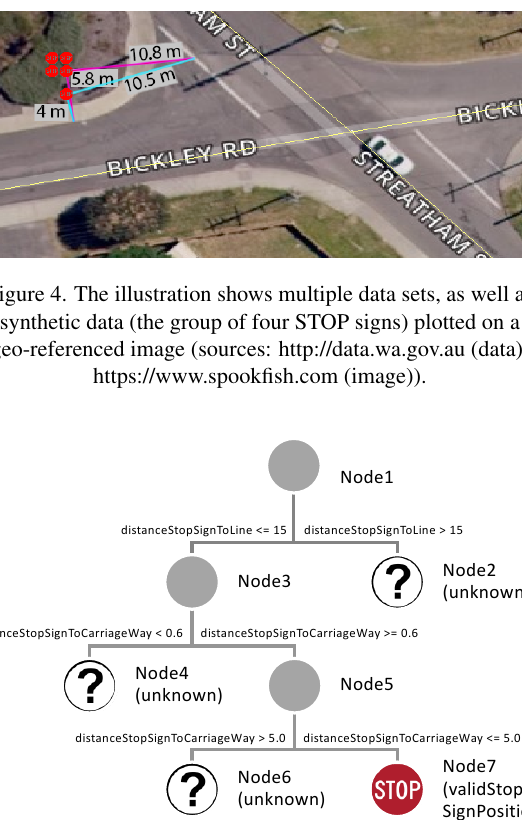
Figure 5. A visualised decision tree to validate the position of a STOP